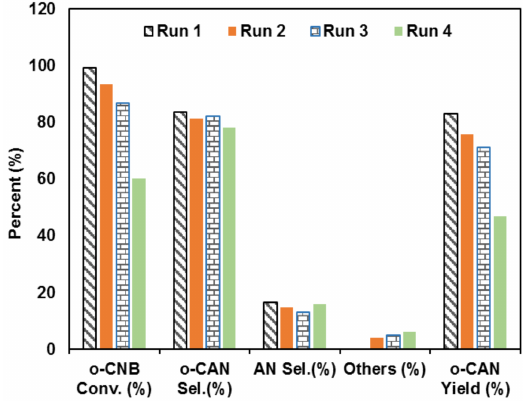
Figure 11. The recycling data of the o -CNB hydrogenation over UV-irradiated 0.2%Pd/NiO catalyst. Conditions: P (H 2 ) = 1 MPa, 60 ◦ C, 0.5 h, m cat. = 40 mg, n o-CNB / n Pd = 8000:1, V ethanol = 5 mL.